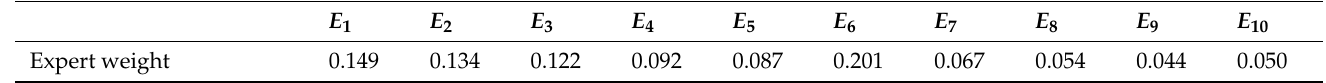
Table 12. Experts’ relative degree of agreement for the calculation of risk parameters’